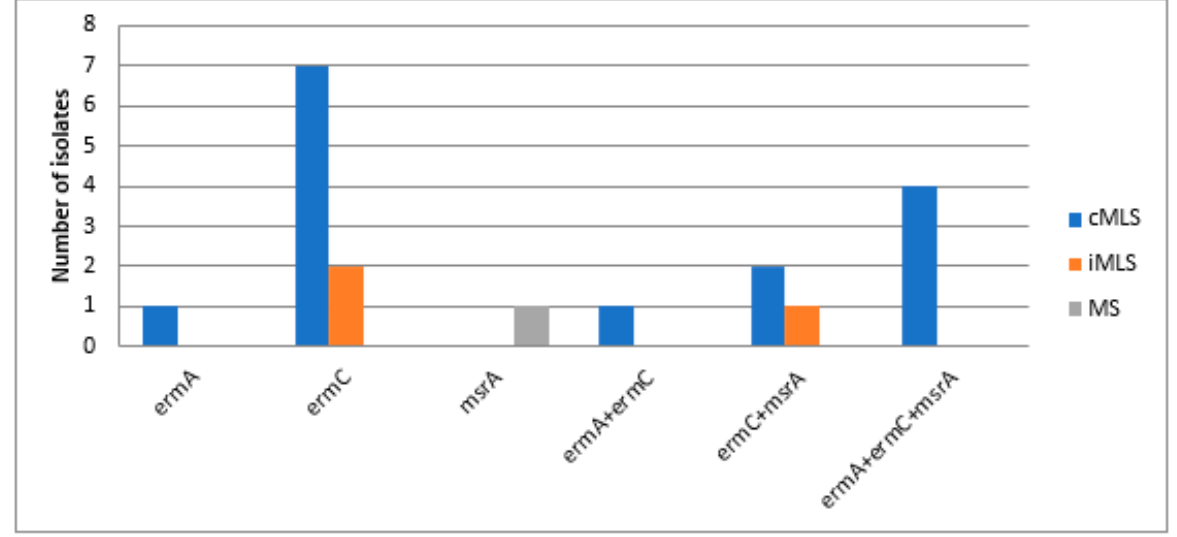
Figure 4. Distribution of MAC-resistance genotypes among the resistant coagulase-negative Staphylococcus sp. isolates. erm A: erythromycin 23S ribosomal methylase gene A. erm C: erythromycin 23S ribosomal methylase gene C, msr : macrolide-streptogramin resistance gene.